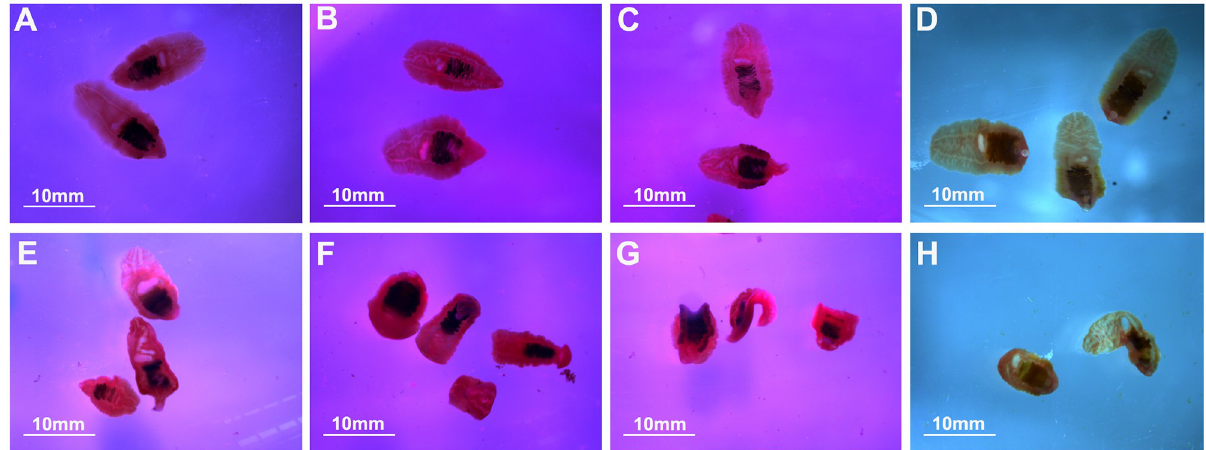
Fig 8. Morphological and moving changes of C . sinensis adults with or without MB05032 treatment. Adult flukes were maintained on high glucose DMEM (A), high glucose DMEM + MB05032 (E), low glucose DMEM (B), low glucose DMEM + MB05032 (F), no glucose DMEM (C), no glucose DMEM + MB05032 (G), 1 × Locke’s (D), and 1 × Locke’s + MB05032 (H), respectively. The images were captured at 5 d of feeding and magnified at × 32.